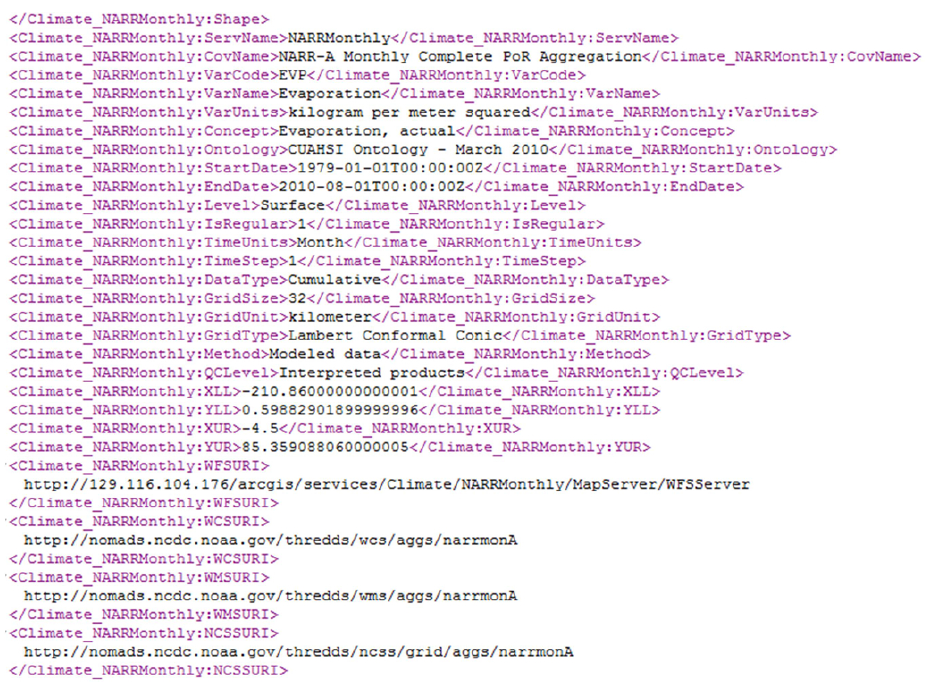
Fig. 8. Example Web Feature Service (WFS) response containing coverage metadata.